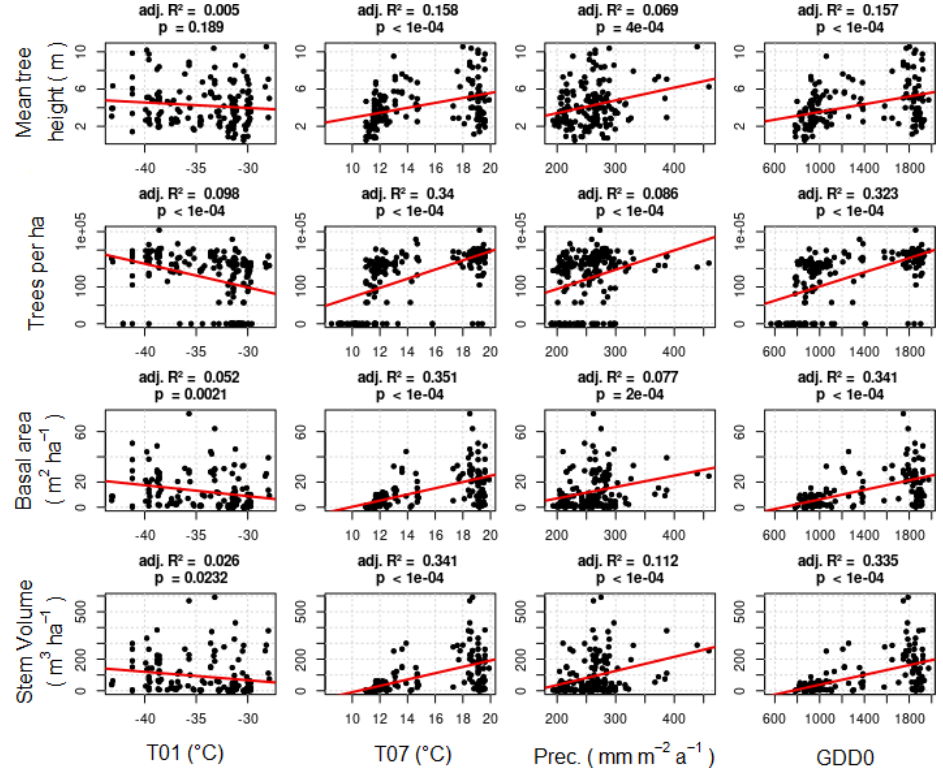
Figure 7. Comparison of forest inventory variables with climate variables. Linear regression lines are given in red.